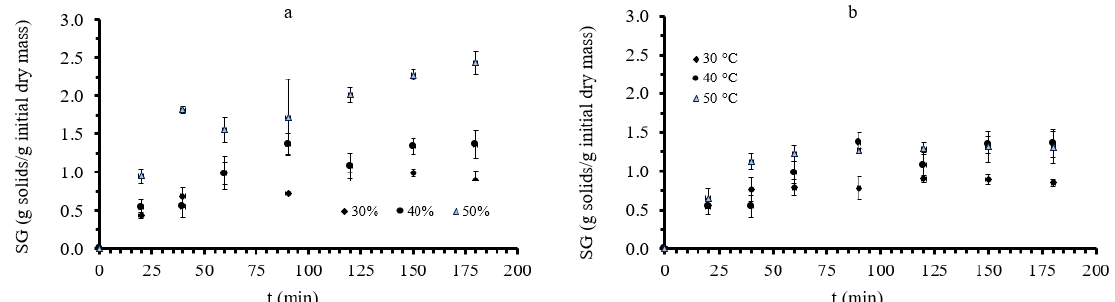
Figure 3. ( a ): Solid gain (SG, g solids/g initial dry mass) during osmotic dehydration at 40 °C, at all three different glycerol concentrations and ( b ) solid gain during osmotic dehydration at 40% glycerol concentration, at all three different temperatures. Points represent average values, and error bars represent the standard deviation, as calculated from the three measurements.